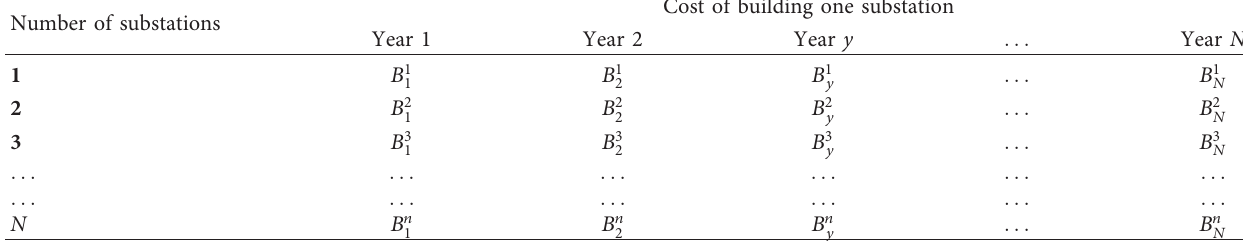
Table 1: The number of substations and the unit building